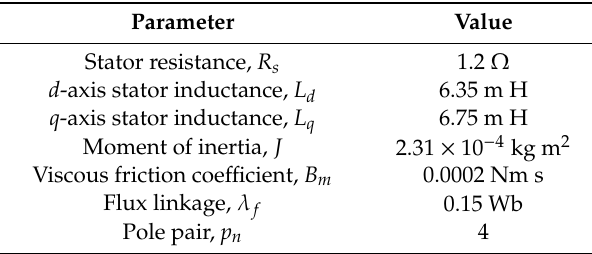
Table 1. Parameters of PMSM.